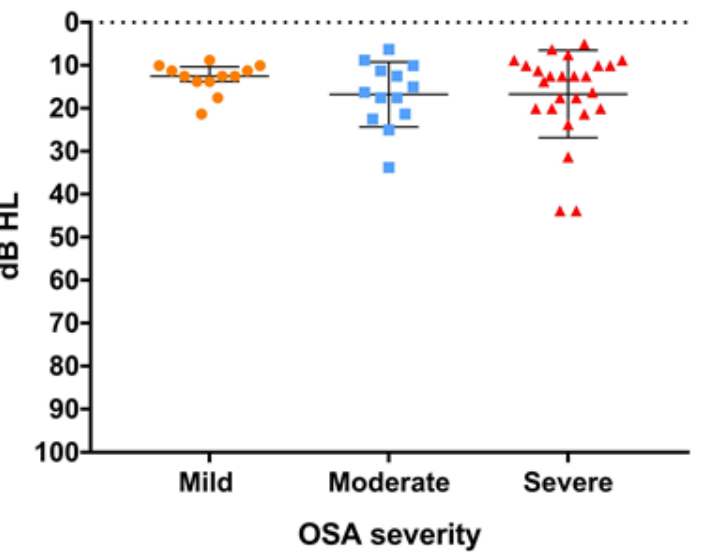
Figure 3. Pure tone average (PTA) of the worse ear is shown with scatter dot plot (line: median and interquartile range) and grouped (mild, moderate, severe) according to obstructive sleep apnea (OSA) severity. The difference in PTA between OSA severities showed no statistical significance. ( p = 0.52). Table 1. Comparisons in demographic data, tinnitus data and polysomnographic data between tinnitus and non-tinnitus groups.